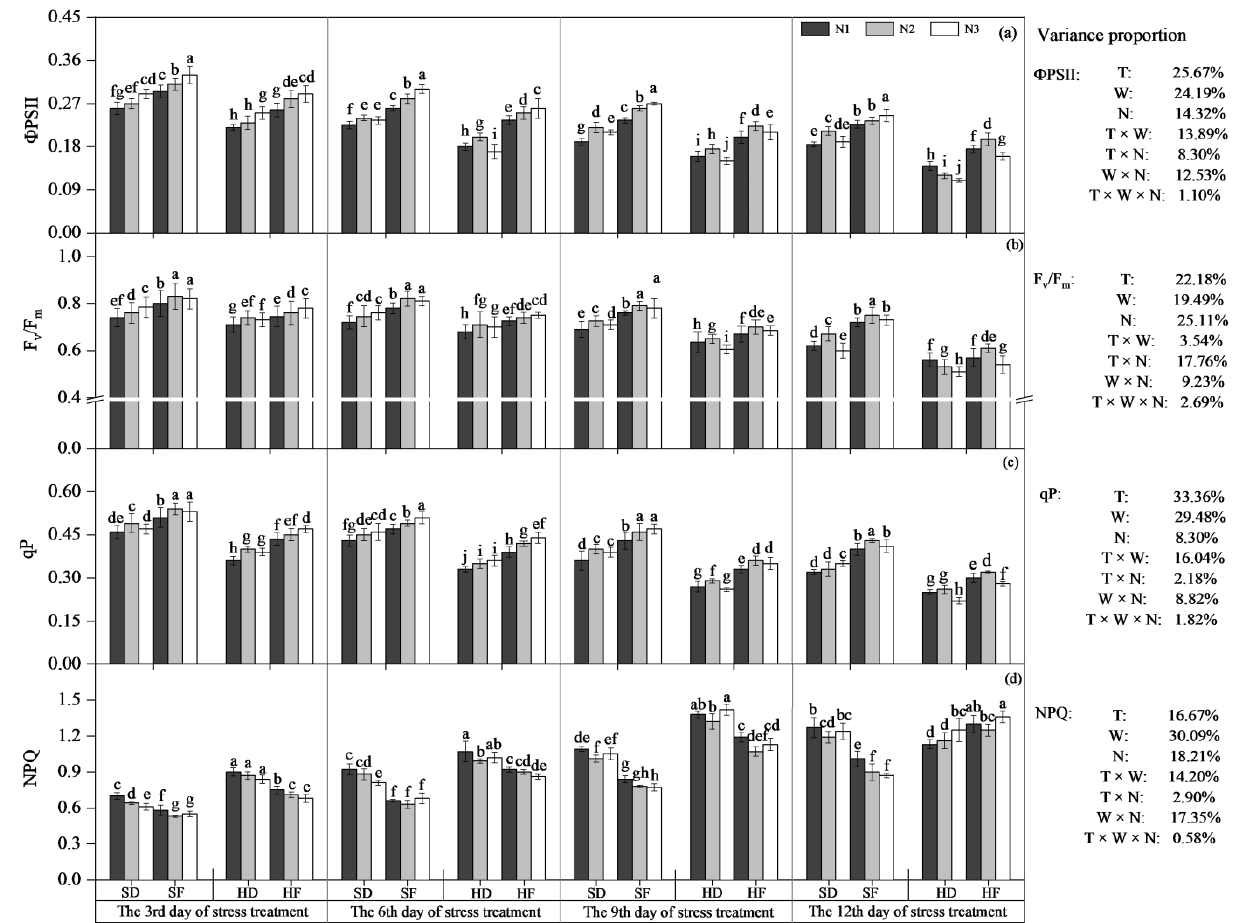
Figure 4. Effects of N application on the efficiency of PSII photochemistry ( Φ PSII, a ), maximum efficiency of PSII photochemistry (F v /F m , b ), photochemical quenching coefficient (qP, c ) and non- photochemical quenching coefficient (NPQ, d ) in the leaves of wheat under short-term heat, drought and combined stress after anthesis. SD: suitable temperature + drought stress; HD: heat + drought stress; HF: heat stress + full watering; SF: suitable temperature + full watering. T: temperature; W: watering; N: nitrogen. The values are the means ± standard deviation, n = 5. Different lowercase letters indicate statistically significant differences ( p < 0.05). The right side of the figure shows the proportion of variance explained by each factor and